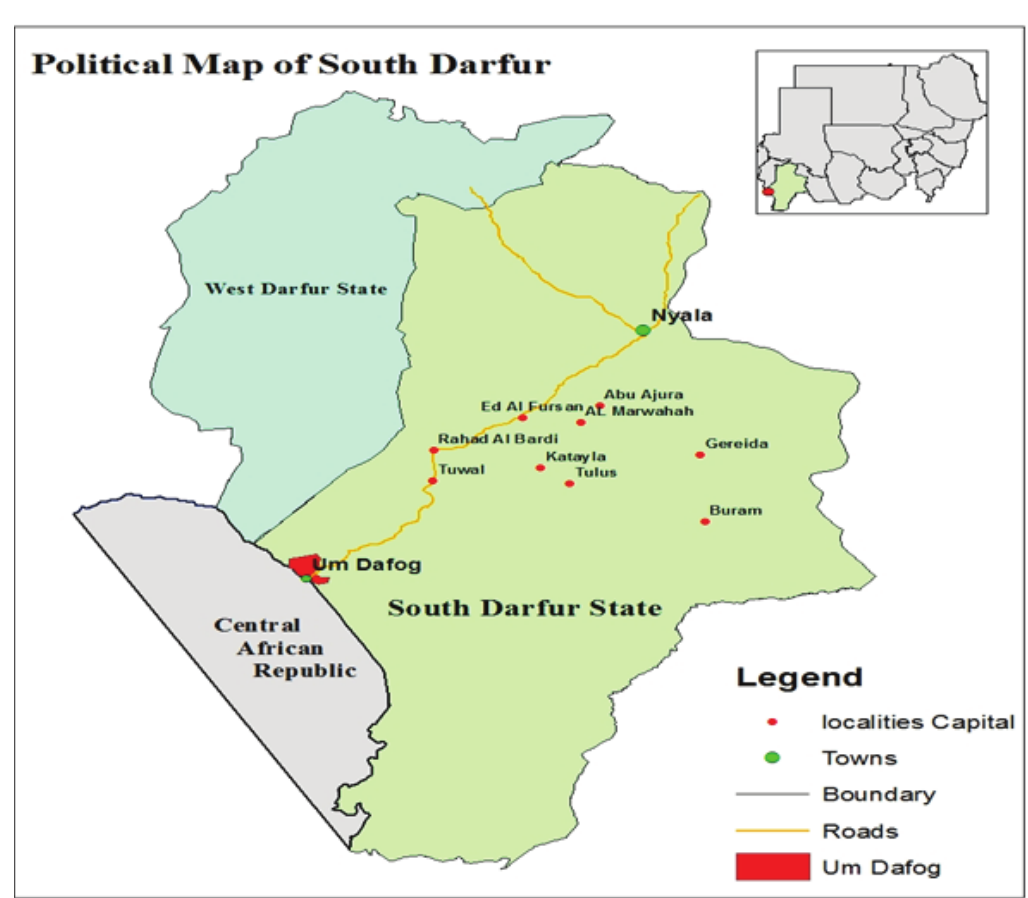
Figure 1: A map of south Darfur State showing the study